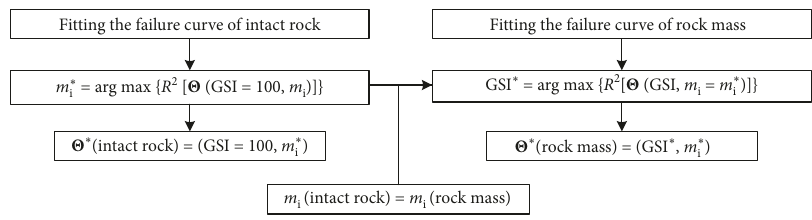
Figure 5: Determination procedure of Hoek–Brown strength parameters.